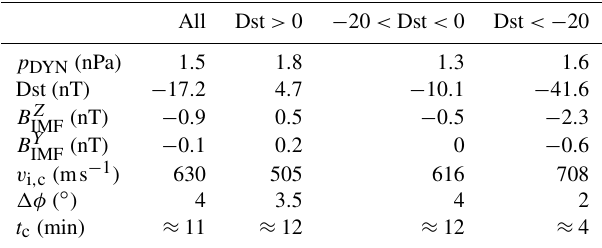
Table 1. Used input parameters in the geomagnetic model for differ- ent conditions. The first column shows the corresponding average of the full